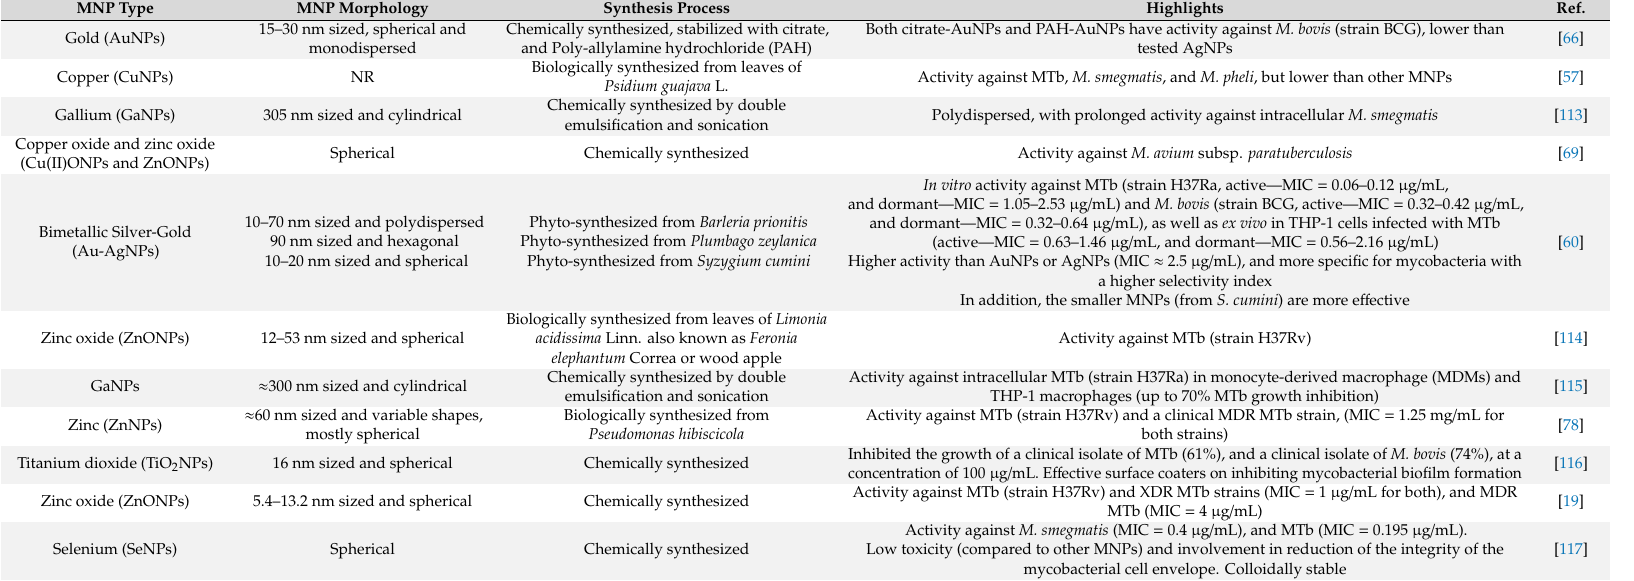
Table 5. MNPs (other than AgNPs) with reported activity against